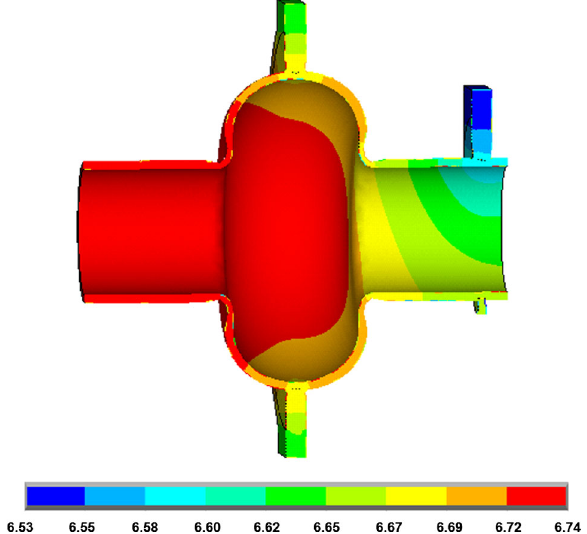
FIG. 34. Temperature distribution for the 952.6 MHz prototype ¼ 47 mT cavity cooled by 3 CCRs, calculated with Ansys for B p ¼ 16 . 9 W which resulted in a stable at the maximum P rf solution. The temperature color map scale is in units of